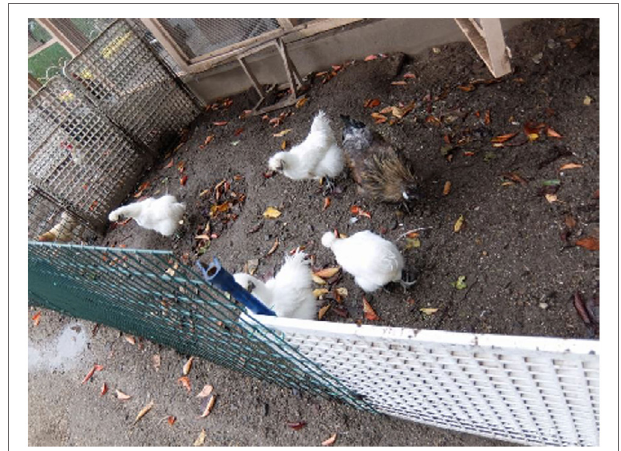
FiGURe 2 | Animals in the animal house of the